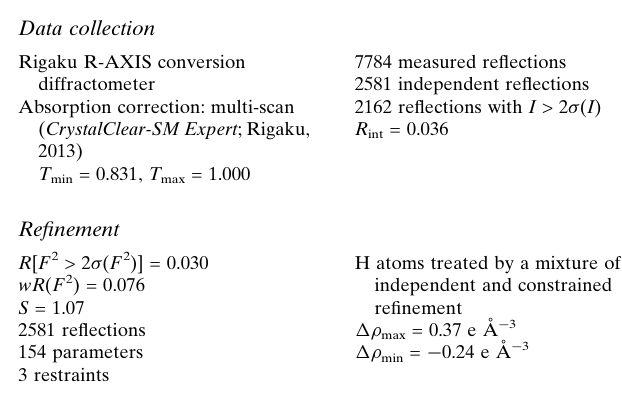
Absorption correction: multi-scan ( CrystalClear-SM Expert ; Rigaku,